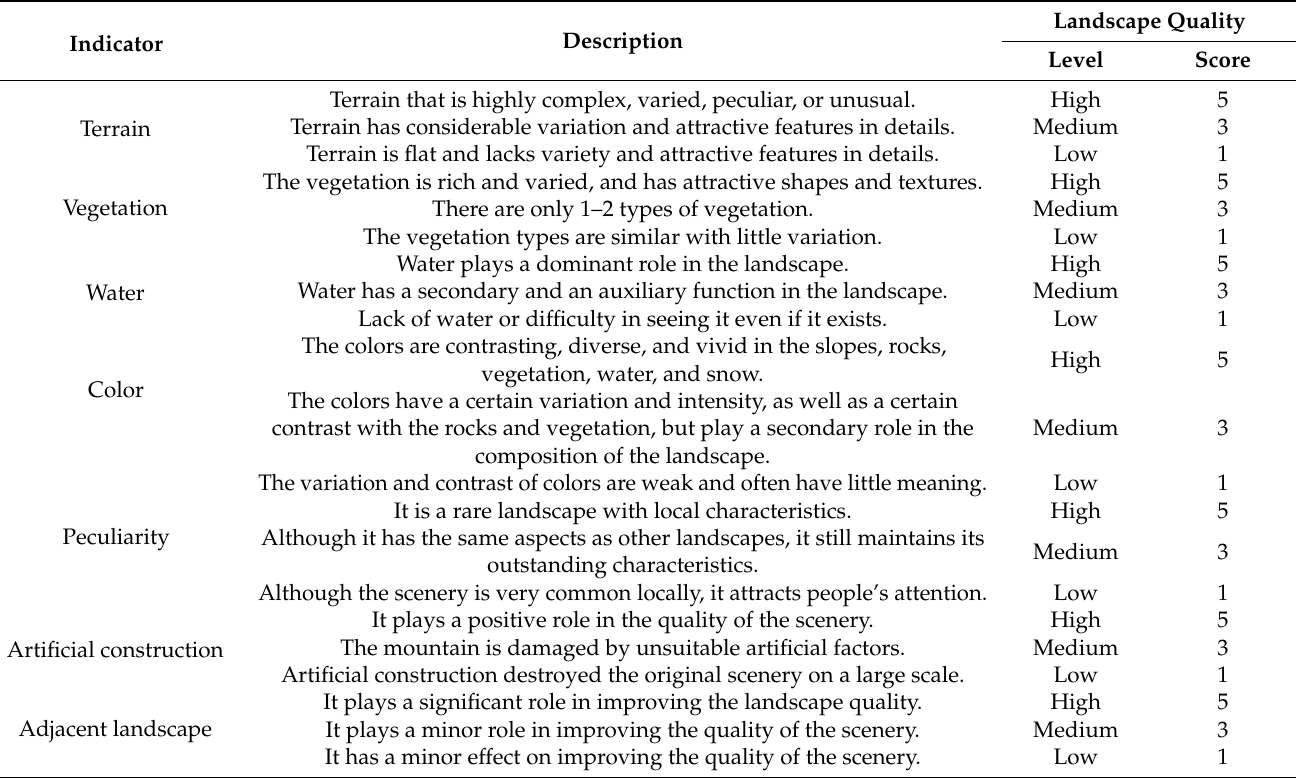
Table 3. Evaluation criteria of landscape remarkableness evaluation